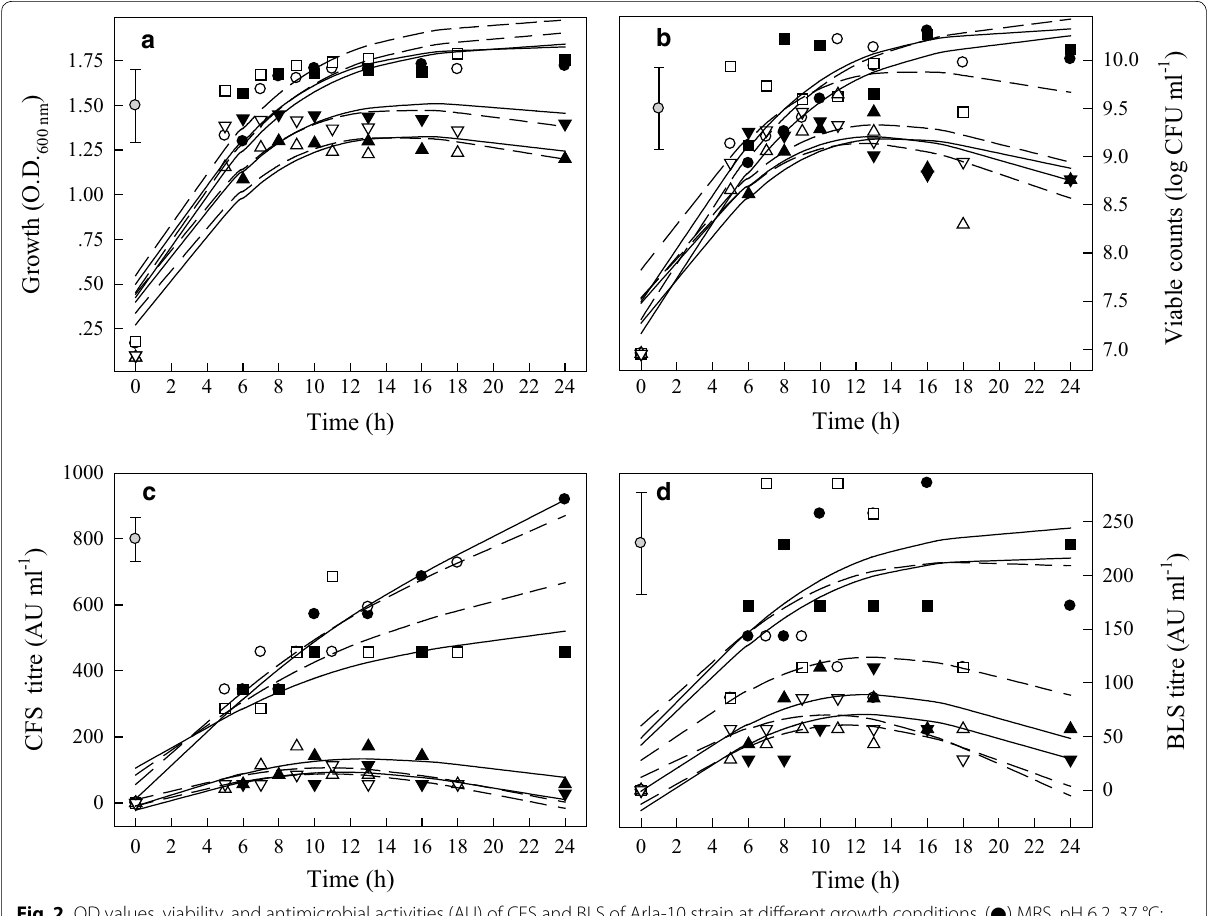
Fig. 2 OD values, viability, and antimicrobial activities (AU) of CFS and BLS of Arla-10 strain at different growth conditions. ( ● ) MRS, pH 6.2, 37 °C; ( ○ ) MRS, pH 6.2, 44 °C; ( ■ ) MRS, pH 7.4, 37 °C; ( □ ) MRS, pH 7.4, 44 °C; ( ▲ ) BHI, pH 5.5, 37 °C; ( △ ) BHI, pH 5.5, 44 °C; ( ▼ ) BHI, pH 6.2, 37 °C; ( ▽ ) BHI, pH 6.2, 44 °C. a Optical density (OD); b LAB viable counts; c antimicrobial activity of CFS and d antimicrobial activity of BLS. The experimental data were fitted to the logistic model. The vertical bar represents standard errors of the